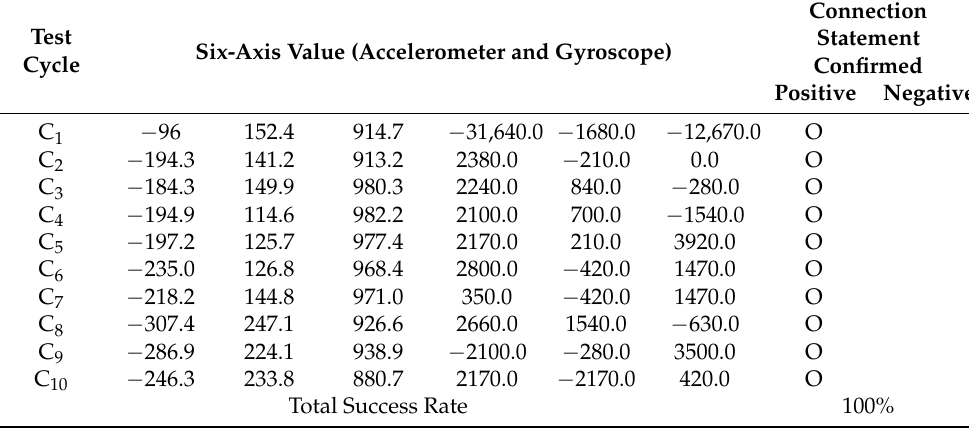
Table 4. Connection success check test